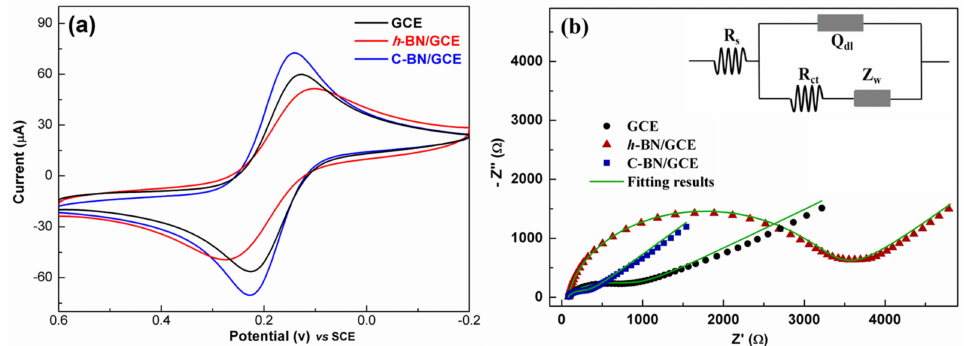
Figure 4. ( a ) CV and ( b ) EIS plots of 1 mM [Fe(CN) 6 ] 3 − /4 − in 0.1 M KCl solution for GCE, h -BN/GCE and C-BN/GCE. Inset displaying the equivalent circuit for EIS tests.